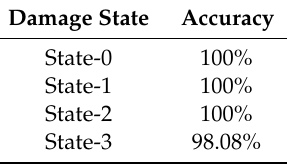
Table 5. Accuracy of each class.